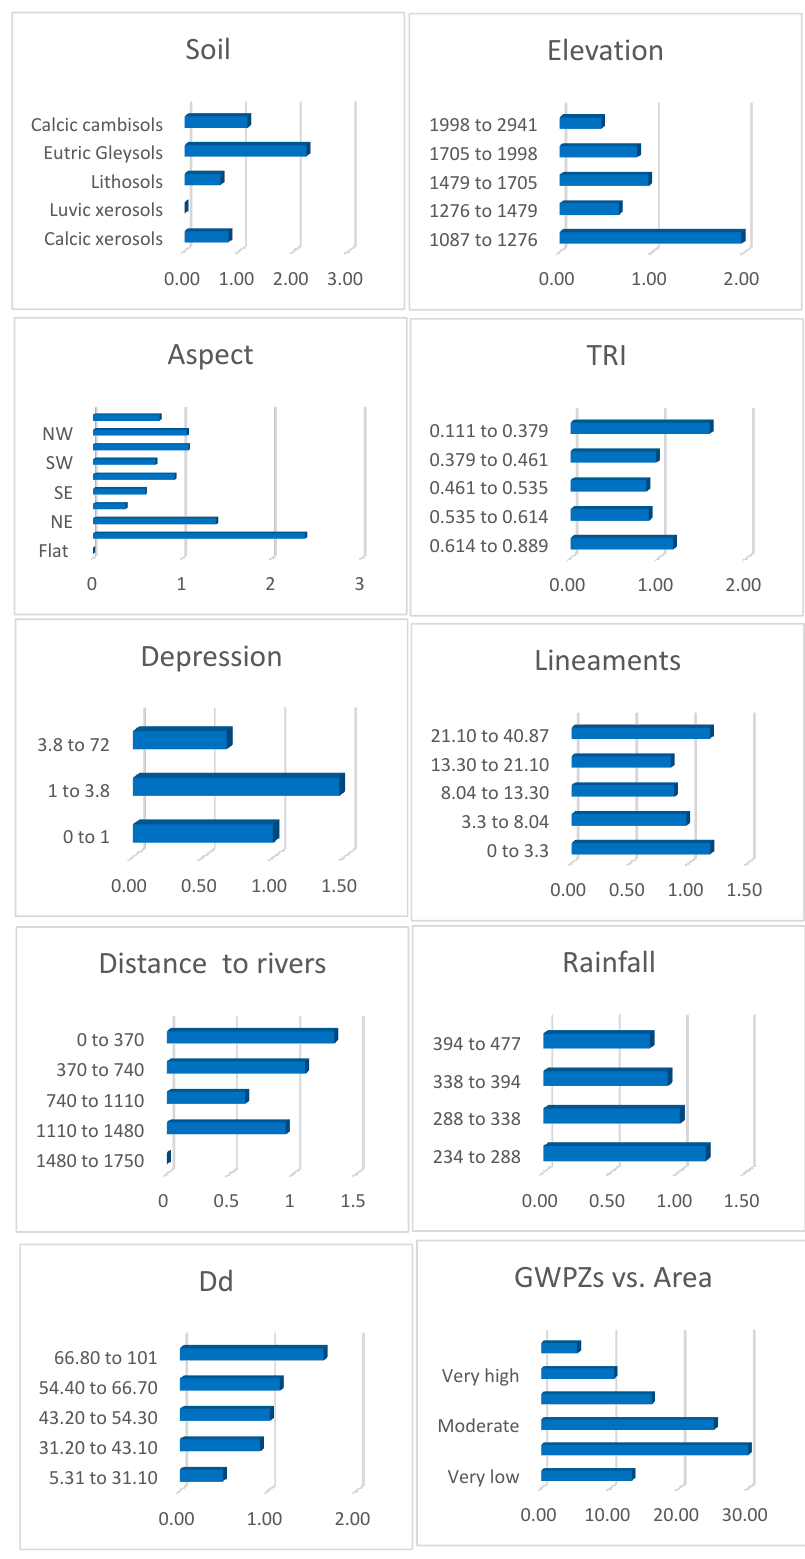
Figure 8. A two-dimensional bar chart, for comparing the FR values among classes of the influencing factors (e.g., soil, elevation, aspect, TRI, depressions, lineaments, distance to rivers, rainfall, and drainage density (Dd)) and the areas covering the